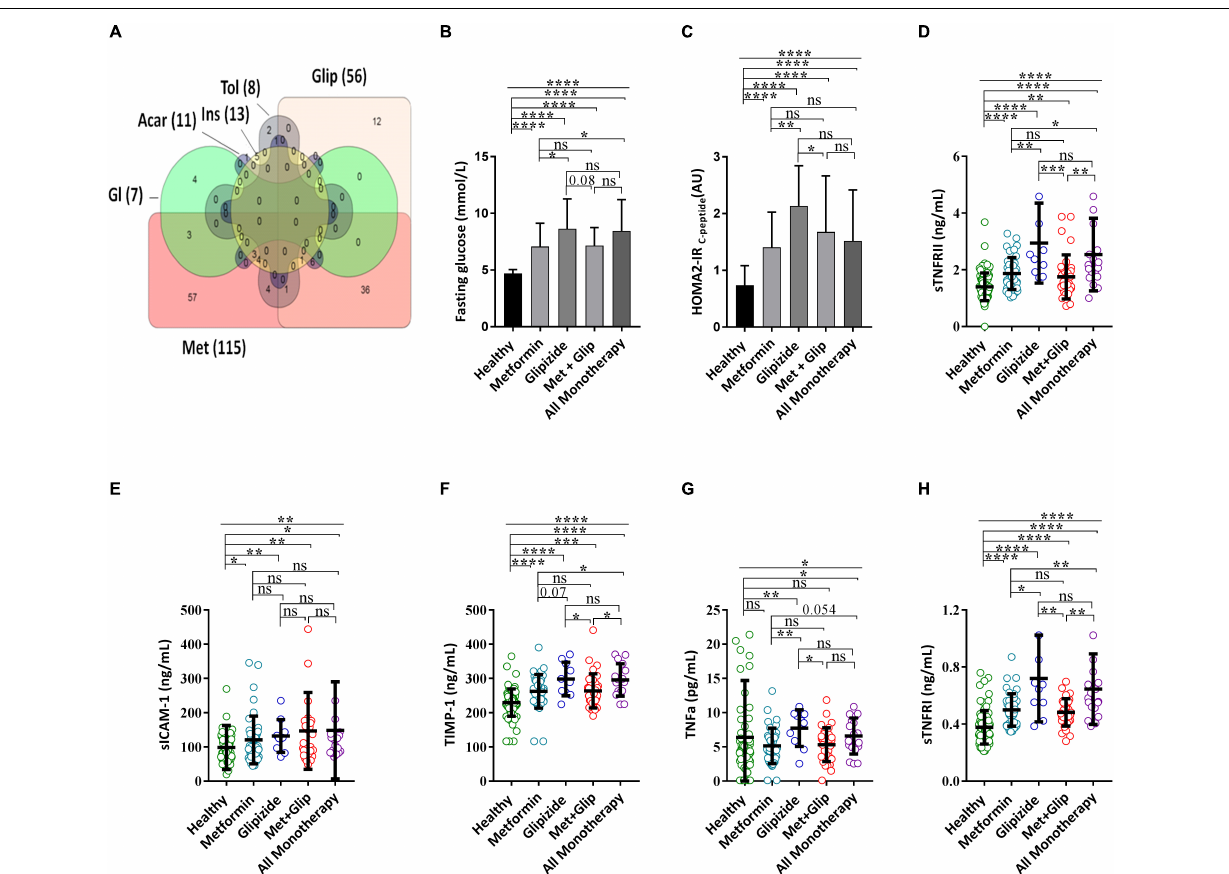
Frontiers in Physiology |